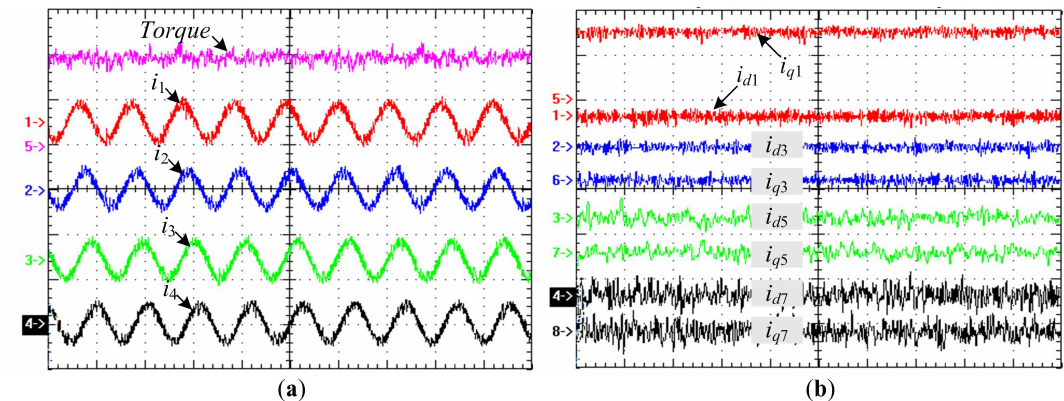
Figure 13. Experimental evaluation of steady-state performance with fully decoupled current control. ( a ) (Traces 1–4) Measured phase current waveforms, and (Trace 5) measured torque (6 ms/div, 5 A/div, 50 N·m/div); ( b ) (Traces 1–8) Measured synchronous current components (6 ms/div, 2